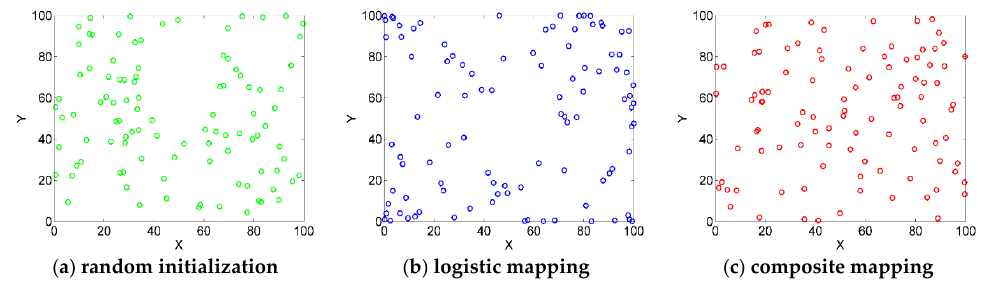
Figure 1. One Hundred search agents generated by three methods.